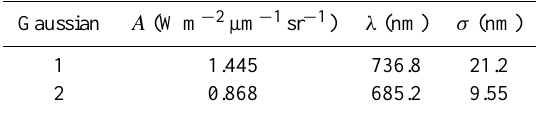
Table 1. Parameters of the fluorescence spectral shape model used in